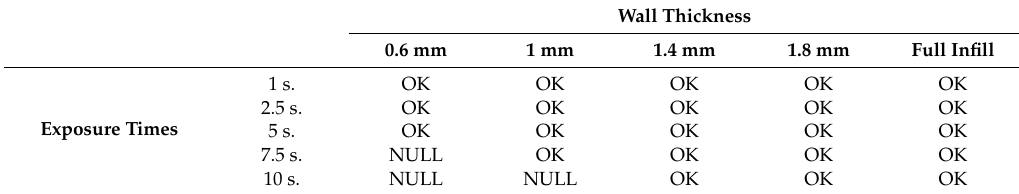
Table 7. Simple compression strength test for di ff erent wall thicknesses and exposure times with a layer height of 0.06 mm.